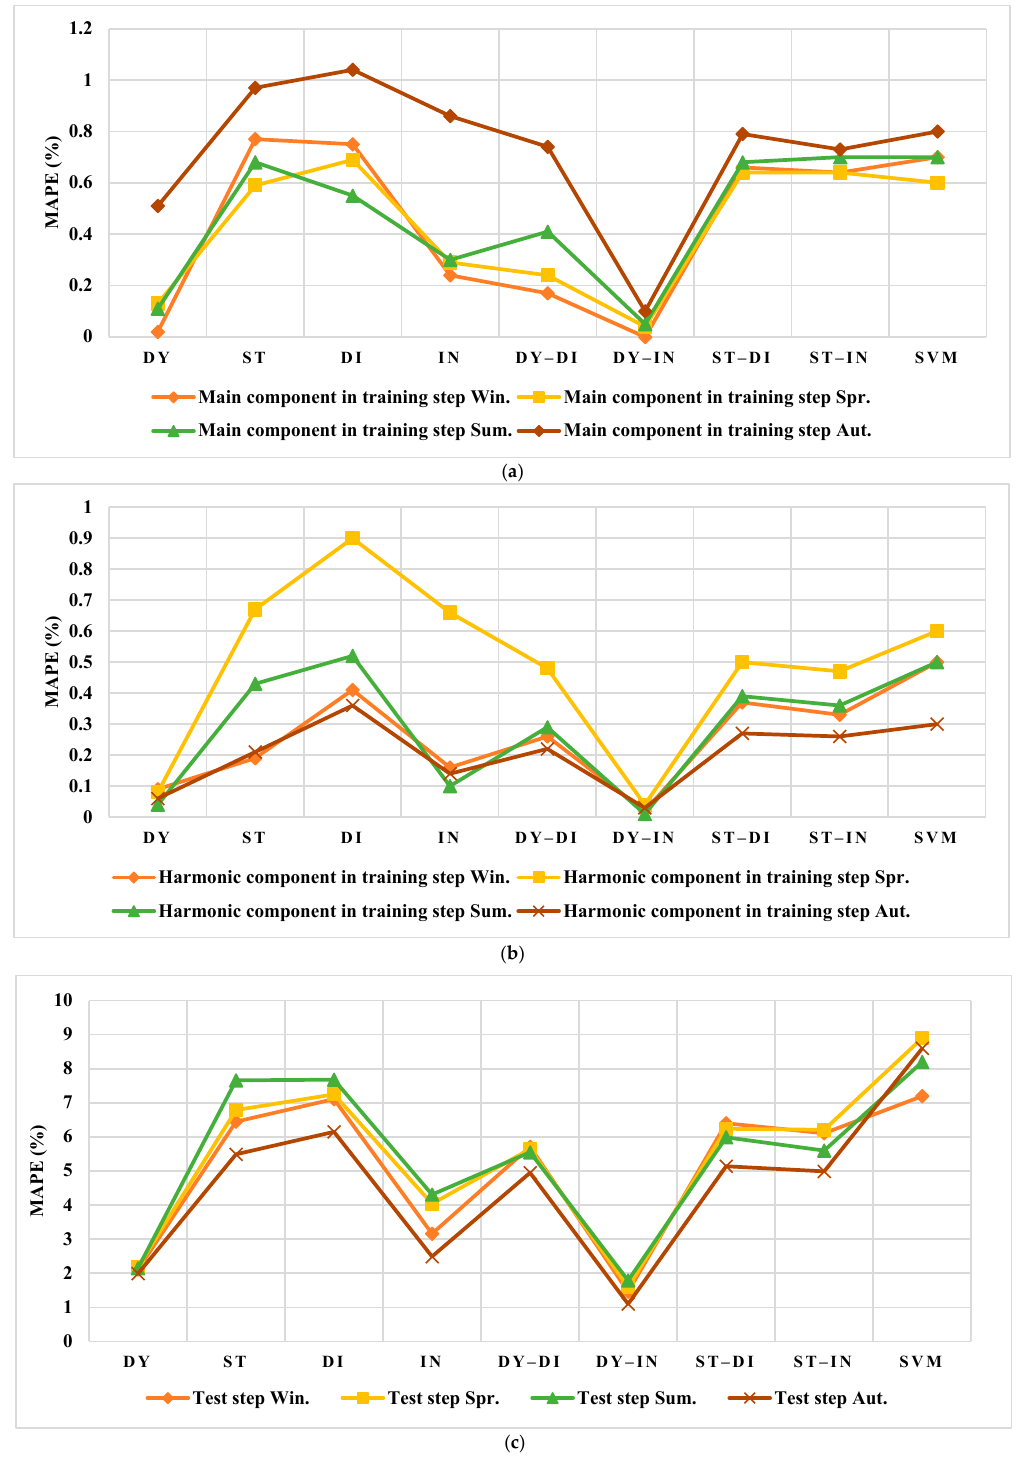
Figure 11. The results of MAPE (%) for Spain: ( a ) Main Component in training step, ( b ) Harmonic Component in training step, ( c ) Test step The results of NRMSE are presented in Figure 12. In this figure, the lowest values are related to the dynamic indirect GP. Other methods are weak in comparison with this method. Additionally, the best result obtained by the dynamic indirect GP in the test data is related to the winter with 0.43%. In addition, the NRMSE results of SVM are much higher than those of DY–IN, and are close to the DI and ST models. ( a )